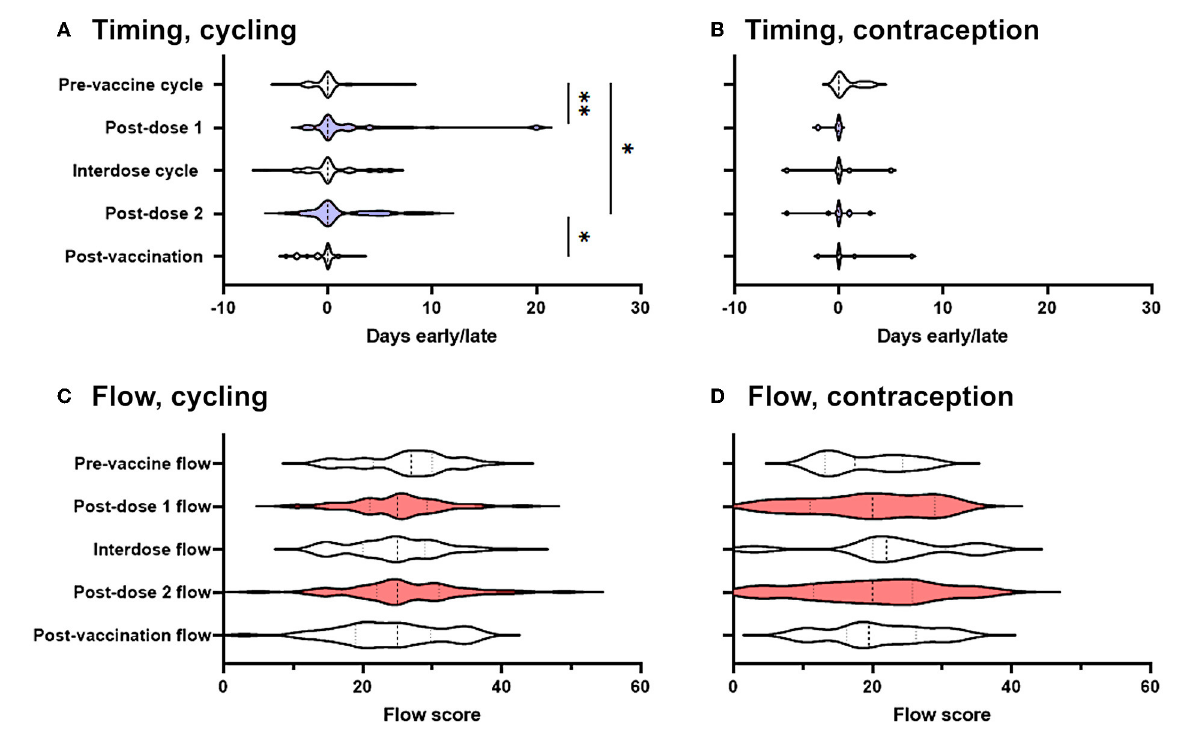
FIGURE2 Effect of COVID-19 vaccination on menstrual timing and flow in a prospectively-recruited cohort. (A,B) Violin plots showing the distribution by which periods or withdrawal bleeds began in pre-vaccine cycles, the cycle following dose 1 of the COVID-19 vaccine, interdose cycles, the cycle following dose 2 of the COVID-19 vaccine, and subsequent cycles, where “0” denotes the period or withdrawal bleed beginning on the expected day, negative numbers denote days early and positive numbers days late. Data for spontaneously cycling (A) and participants on hormonal contraception (B) are shown. (C,D) Violin plots showing the distribution of flow scores for periods or withdrawal bleeds in pre-vaccine cycles, the cycle following dose 1 of the COVID-19 vaccine, interdose cycles, the cycle following dose 2 of the COVID-19 vaccine, and subsequent cycles. Data for spontaneously cycling (C) and participants on hormonal contraception (D) are shown. The post-vaccine cycles are shaded as a visual aid. Statistical testing with a mixed effects model, with Tukey’s test for multiple comparisons. * adjusted p < 0.05, ** adjusted p <